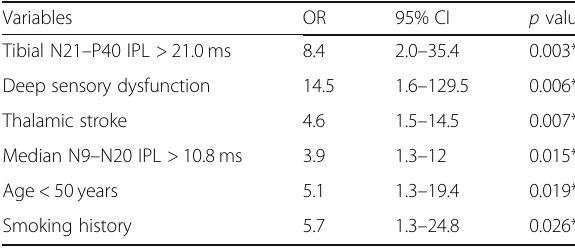
Table 4 Predictors of central post-stroke pain